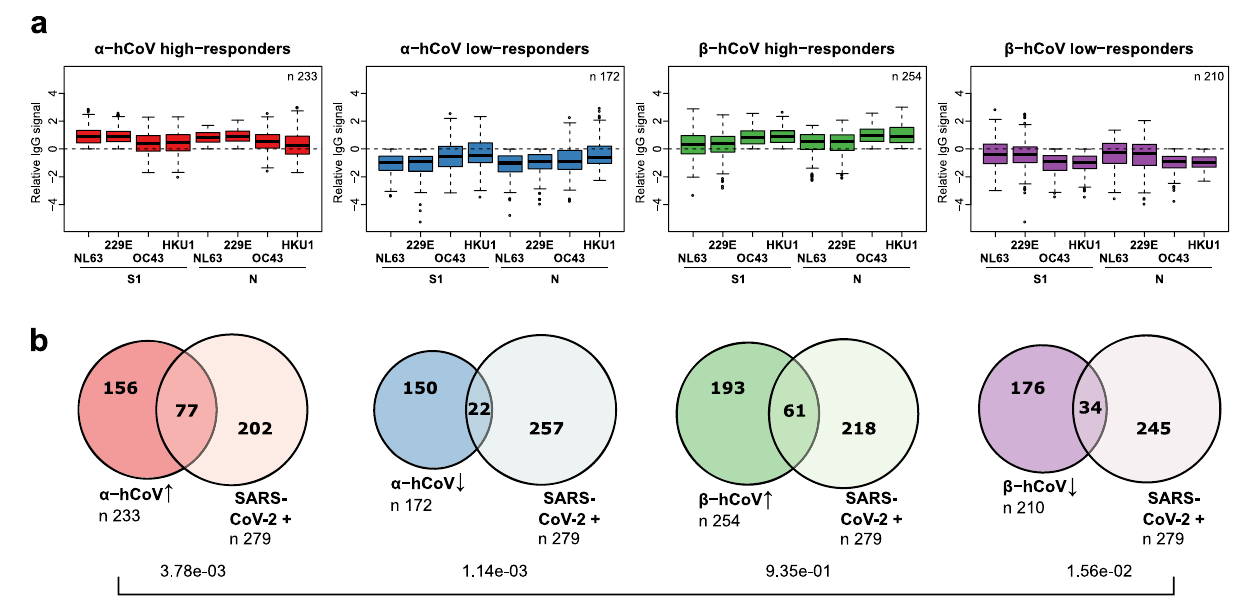
Fig. 5 Analysis of seasonal hCoV high and low responders. a From the entire study population, groups of α - or β -hCoV high and low responders were built as indicated. High responder were de fi ned as samples with above average MFI values for S1 and N-speci fi c IgGs of the respective hCoV clade. Low responders were de fi ned with below MFI values, correspondingly. Responder groups (i) α -hCoV ↑ , red, n = 233, (ii) β -hCoV ↑ , green, n = 254, (iii) α -hCoV ↓ , blue, n = 172 (iv) β -hCoV ↓ , purple, n = 210 are shown as Box-Whisker plots of log-transformed and per-antigen scaled and centered MFI values across hCoV N and S1 antigens. Box represents the median and the 25th and 75th percentiles, whiskers show the largest and smallest values. Outliers determined by 1.5 times IQR are depicted as circles. b The over- or under-representation of SARS-CoV-2 responders (SARS-CoV-2 + , n = 279, as determined by positive MultiCoV-Ab classi fi cation) within the four sample groups is visualized in Venn diagrams, stochastic signi fi cance was calculated using Fisher ’ s exact test (two-sided). Source data are provided as a Source Data fi le.